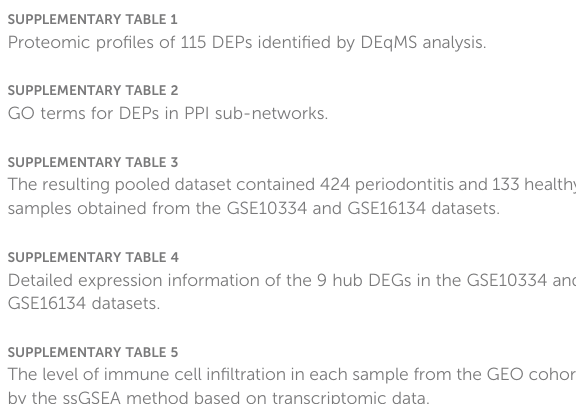
SUPPLEMENTARY TABLE 2 GO terms for DEPs in PPI